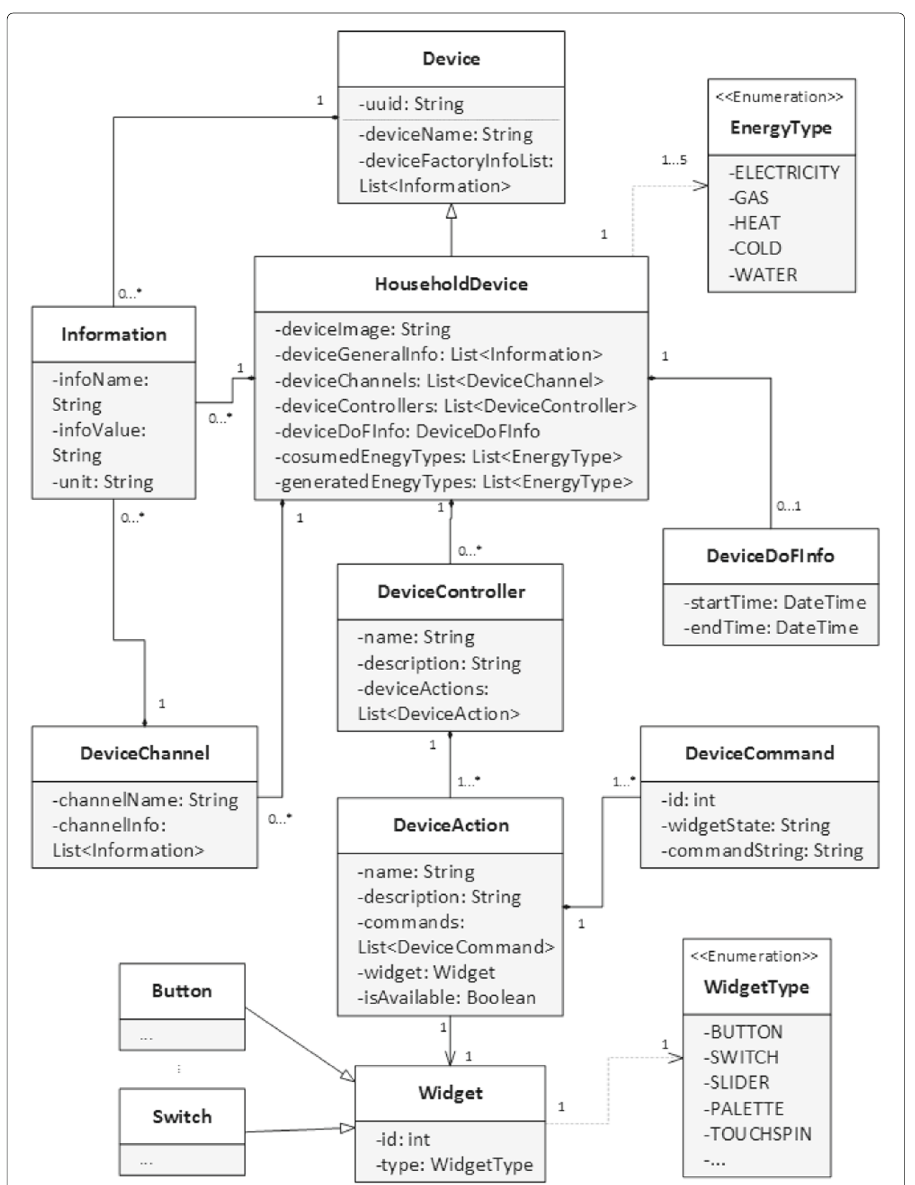
Fig. 4 The UML class diagram of the household device